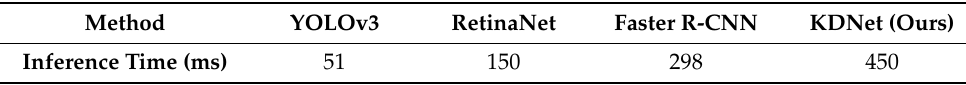
Table 3. Comparison of inference time of different algorithms.